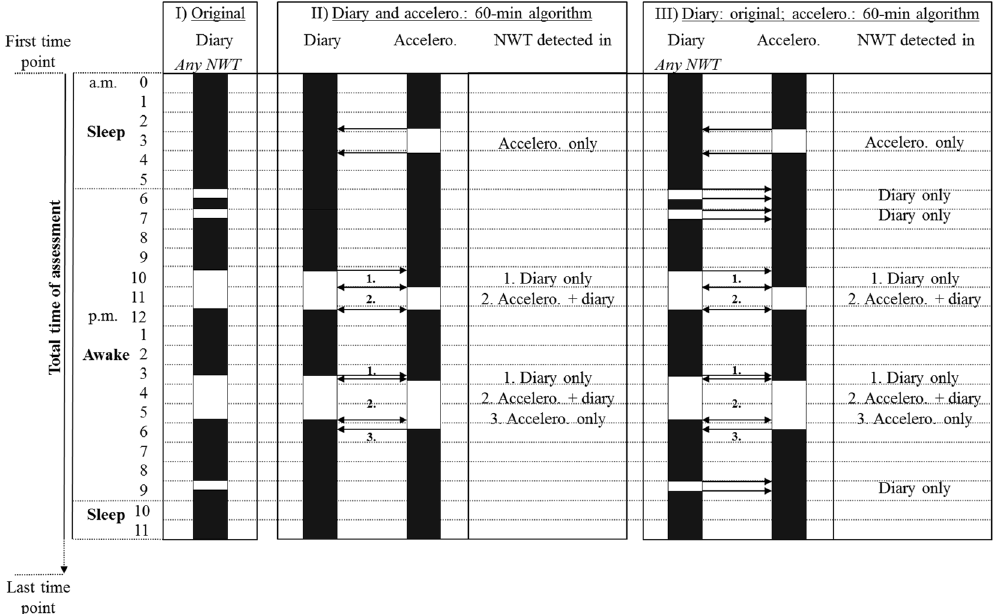
Figure 2. Exemplary description of non-wear time (NWT) validation using a minute-by-minute evaluation for calculation of overlap in length (minutes) of NWT detected based on accelerometry (accelero.) as compared to diary (black rectangles, wear time based on 24 h-accelerometry or diary data, respectively; white rectangles, NWT based on 24 h-accelerometry or diary data, respectively). As an example, in the original diary data (panel I), five NWT periods during waking were reported being 30, 30, 115, 130, and 30 minutes, respectively. When applying the 60-min NWT algorithm (panel II) to both accelerometry and diary data two of all NWT periods in diary (115 and 130 minutes, respectively), and three NWT periods in accelerometry were detected (75, 65, and 140 minutes, respectively). When applying the 60-min NWT algorithm (panel III) to accelerometry data only while any NWT regardless of a minimal length reported in the diary was assessed, still three NWT periods in accelerometry (75, 65, and 140 minutes, respectively) but all five ‘original’ NWT periods in diary (30, 30, 115, 130, and 30 minutes, respectively) were detected. For each NWT algorithm and both approaches (panel II and III), NWT minutes detected by accelerometry only , in diary only and in both accelerometry and diary were assessed. We then calculated the relative contribution of each of these to the potential total NWT (i.e., NWT detected in either diary , accelerometry , or both ). Overlap was defined as the NWT detected in both accelerometry and diary